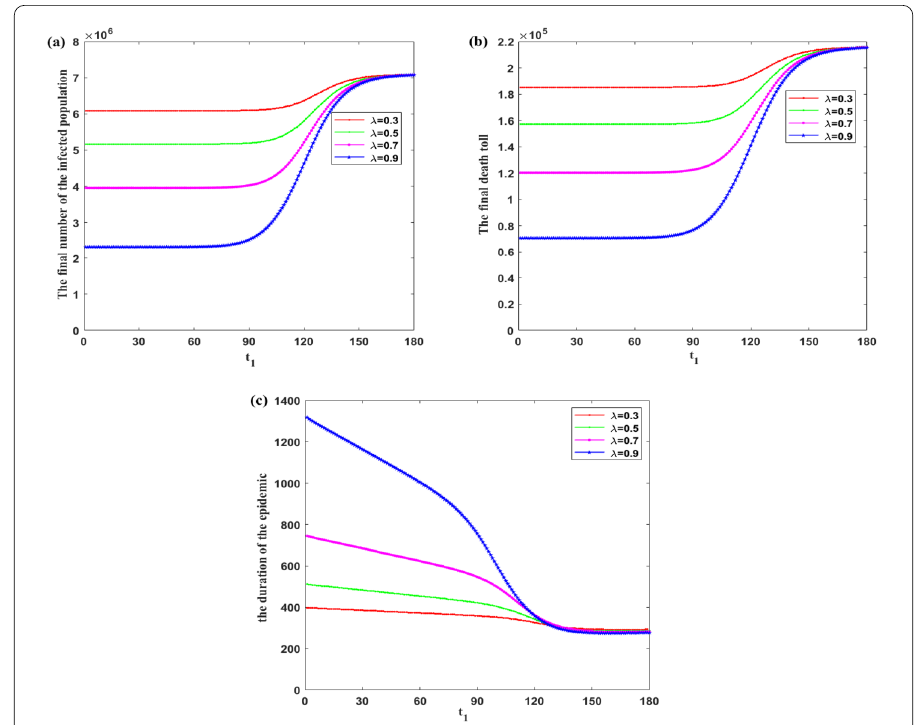
Figure 5 Effects of different moments that the susceptible and exported populations start to wear masks on the final number of the infected population, the final death toll, and the duration of the epidemic under δ = 1, η = 0.4, θ = 0.3, λ = 0.3,0.5,0.7,0.9. Vertical axis: ( a ): the final number of the infected population; ( b ): the